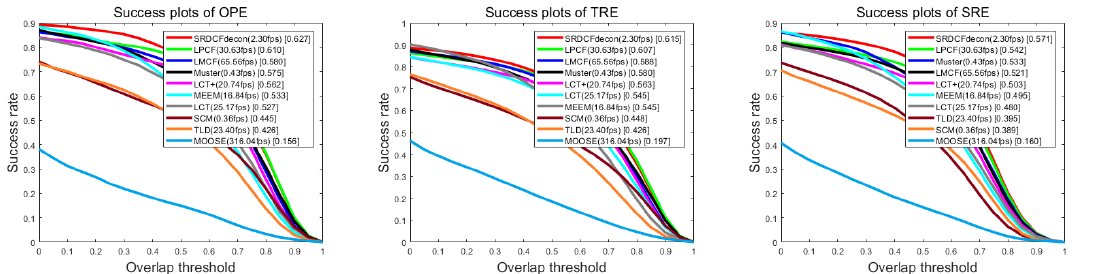
Figure 3. The success plots of OPE, TRE, SRE on OTB-2015. Decontamination trackers are presented at this figure. The numbers in the legend denotes the average AUC scores for success plots. The FPS is also shown in the legend.